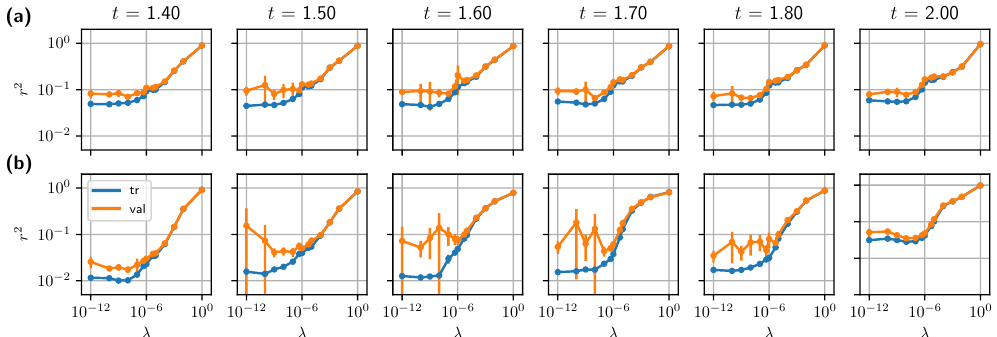
Figure 10: Comparison of the TDVP error r 2 and the validation error r 2 on a loga- tr val rithmic scale for varying regularization strength in the form of the SVD threshold λ at = 0.02 and (b) stronger driving amplitude different points in time for (a) a weak A p = 0.10 on the 8 × 2 ladder system. The TDVP error has been computed here by A p 〉 from the stable λ = 10 − 6 trajectory [ Fig. 6(d),(e) ] taking variational states | ψ θ ( t ) and then performing a single step δ t = 0.002 at each displayed time and for each λ using Metropolis sampling with N = 28 · 10 3 samples. We show here the average s error over five independent realizations of the validation error, with error bars indi- cating the standard deviation, in order to account for variance in the error estimate itself.